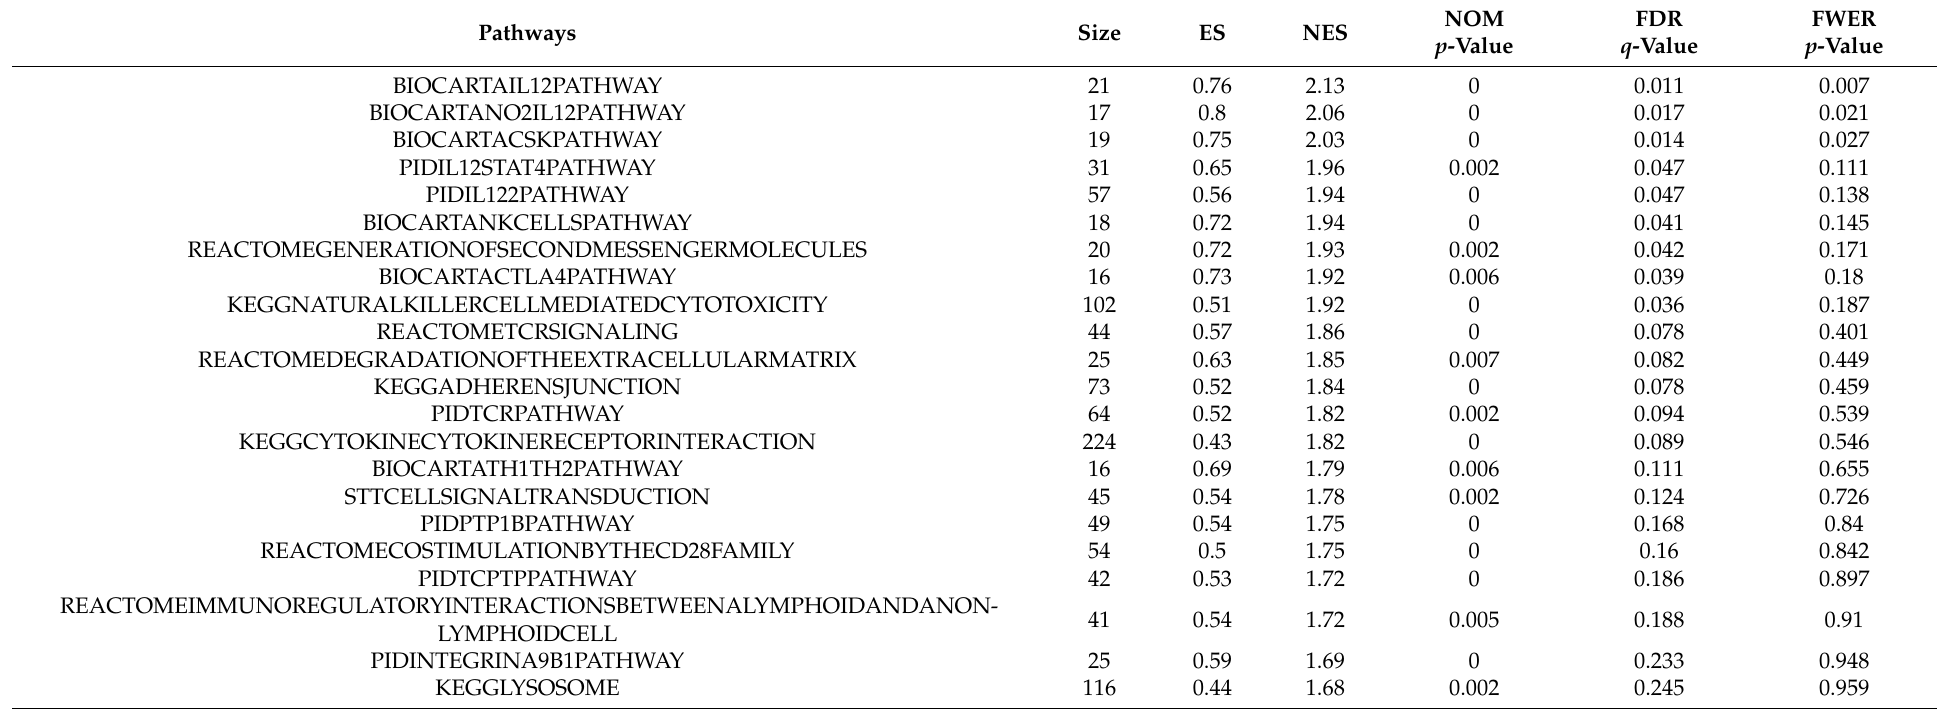
Table 2. Most significantly enriched Gene Set Enrichment Analysis (GSEA) pathways in BAFF group vs. IgG1 CONT.